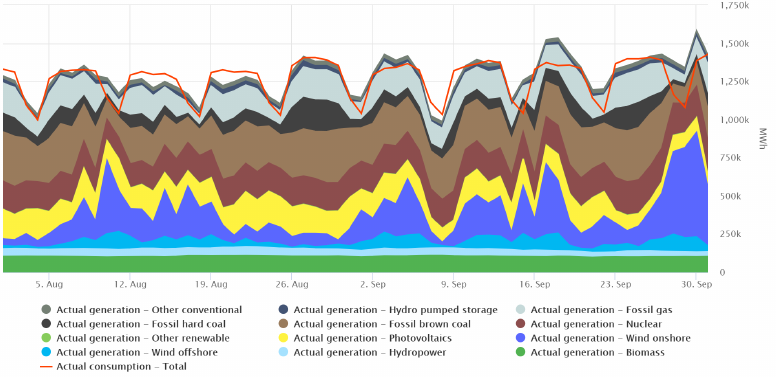
Figure 2. Electricity generation and consumption in August and September 2019. We can see the total electricity generation and consumption every day of the period, see [14] (CC BY 4.0